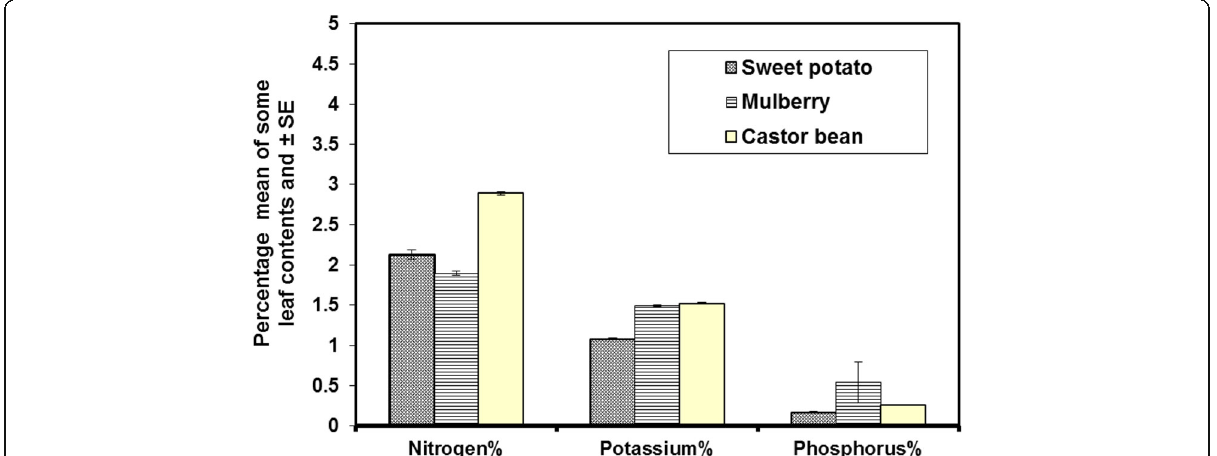
Fig.4 Some leaf contents of nitrogen, phosphorus, and potassium in the three host plant leaves